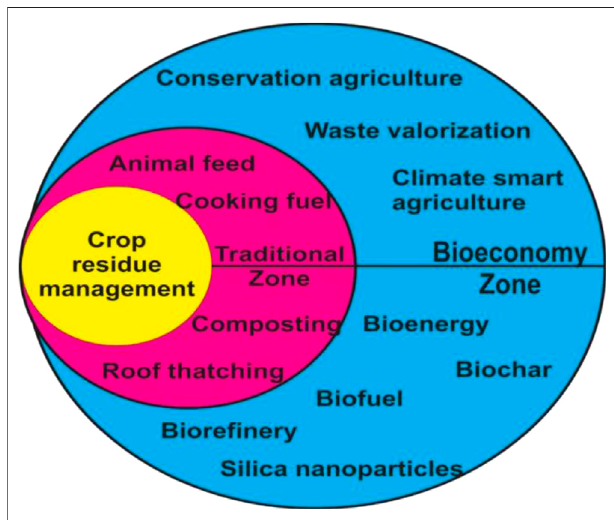
FIGURE 6 | Crop Residue Management: A paradigm shift from the traditional approach to Agricultural Bioeconomy and circular economy.